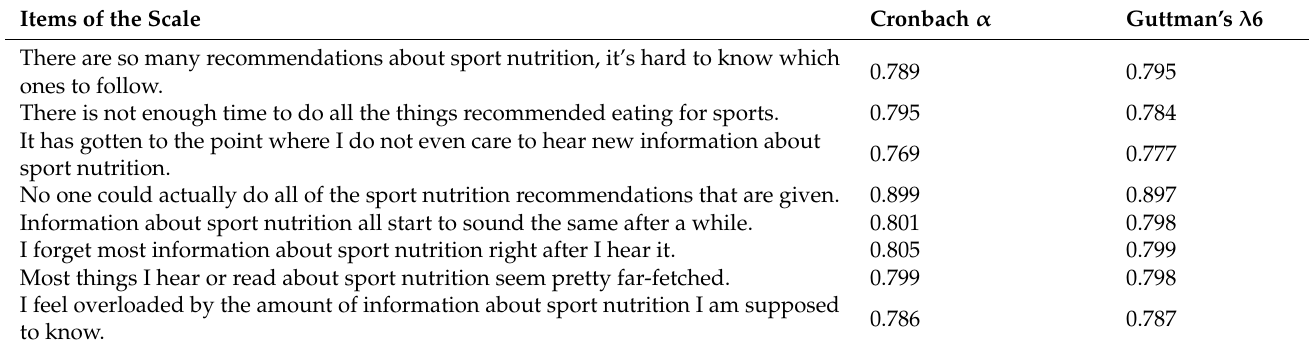
Table 8. Reliability if items are dropped, one by